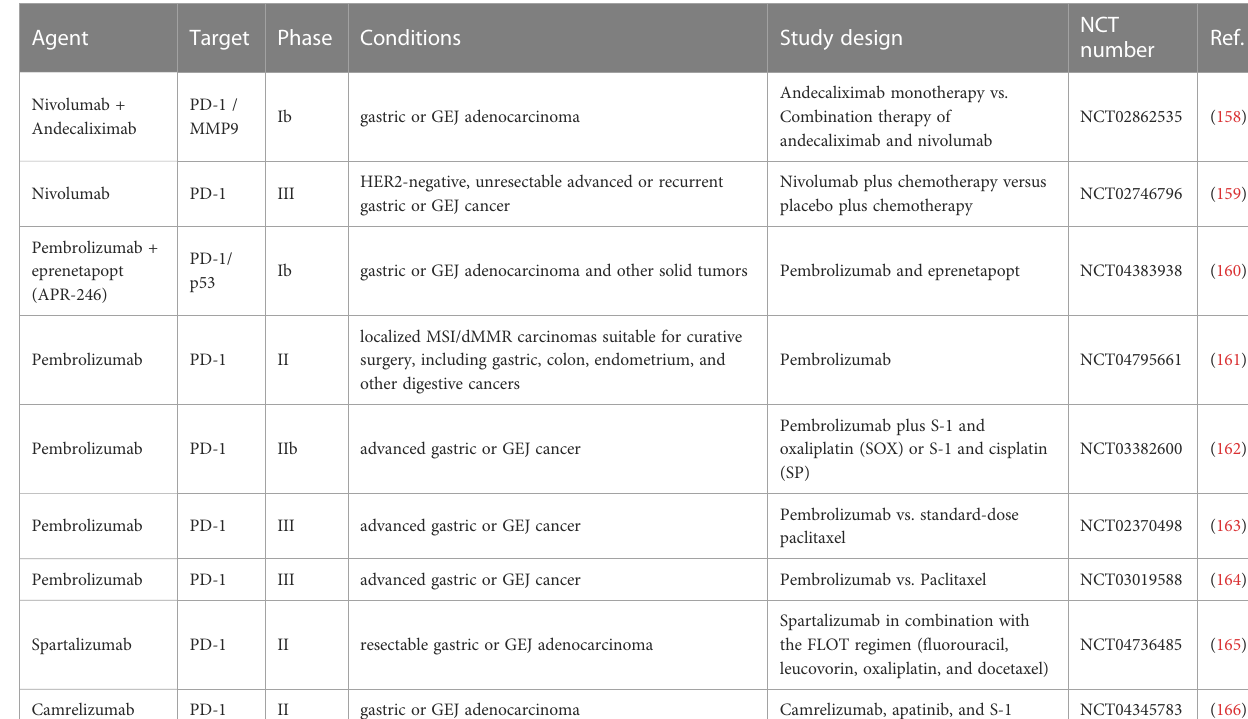
TABLE 1 Overview of the latest representative clinical trials of ICIs in gastric